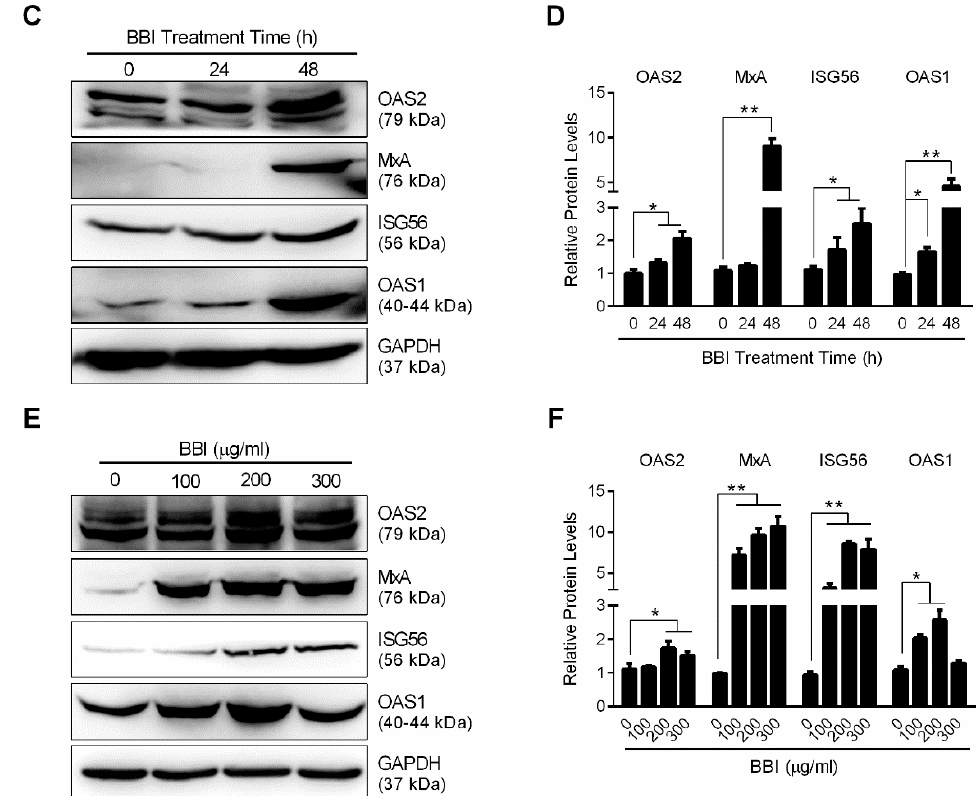
Figure 4. Effect of BBI on the JAK/STAT pathway and ISGs expression. End1/E6E7 cells were treated with or without 200 µ g/mL BBI for indicated times. ( A ) Proteins were collected and analyzed with the antibodies against STAT1, p-STAT1, STAT3, p-STAT3, ISGF-3 γ p48, and GAPDH. ( C ) Proteins were collected and analyzed with the antibodies against OAS2, MxA, ISG56, OAS1, and GAPDH. ( E ) End1/E6E7 cells were treated with BBI at indicated concentrations for 48 h, total proteins were subjected to Western blot. Representative data from three independent experiments were shown. ( B , D , F ) Densitometry analysis of the blots shown in A, C and E were performed with ImageJ 1.44 software. Data shown were obtained as mean ± SD from three independent experiments (* p < 0.05, ** p < 0.01).